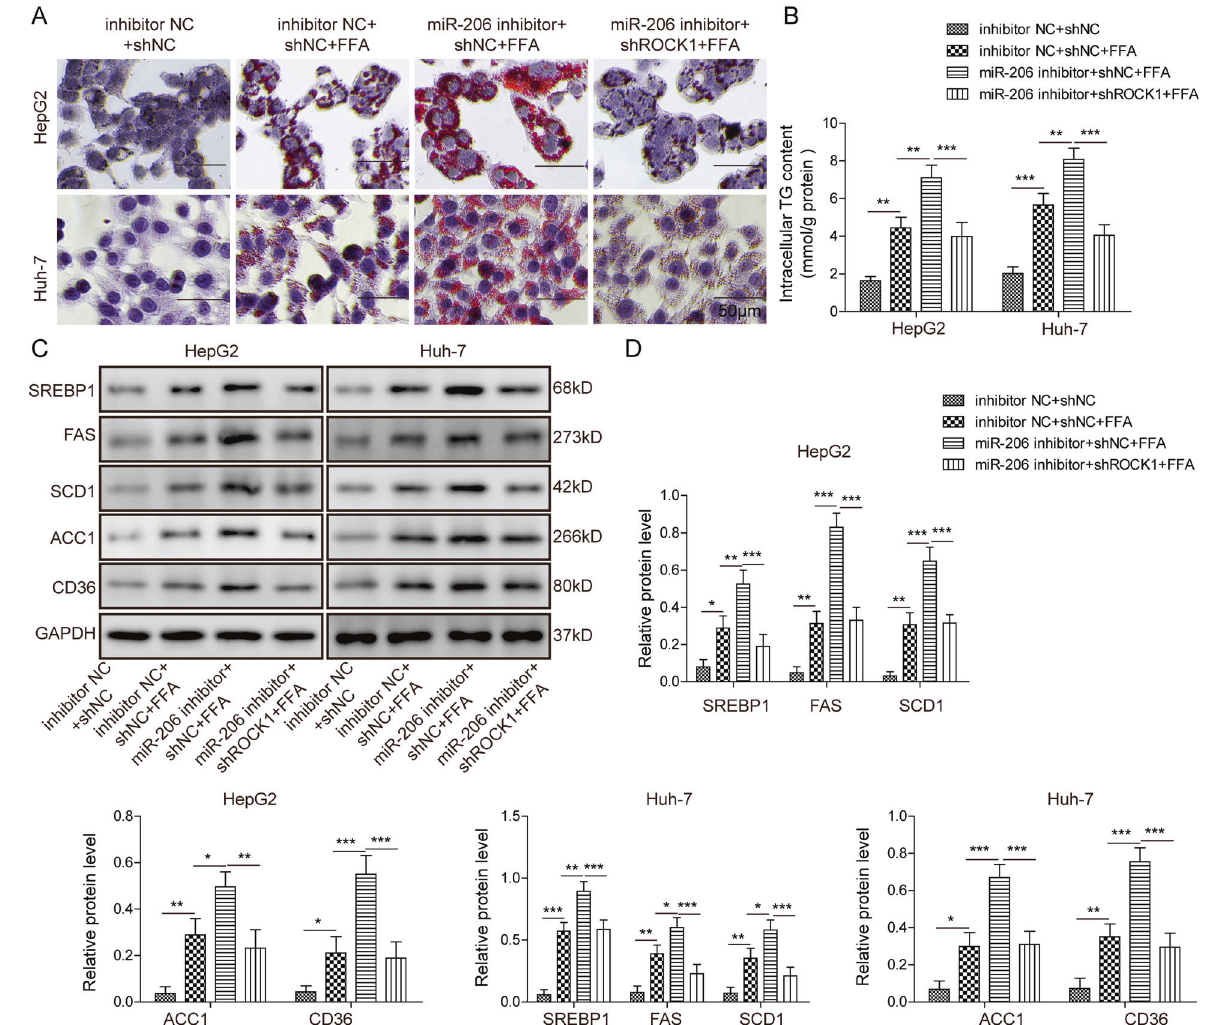
Fig. 4 miR-206 inhibited lipogenesis via ROCK1. A Representative oil-red o staining images of cells with the transfection of miR-206 inhibitor or NC together with sh-ROCK1 or sh-NC following FFA or control treatment. B Secreted TG levels in cells transfected with miR-206 inhibitor or NC together with sh-ROCK1 or sh-NC following FFA or control treatment. C Protein levels of lipogenesis-related proteins in cells with the transfection of miR-206 inhibitor or NC together with sh-ROCK1 or sh-NC following FFA or control treatment. D Quanti fi cations of C . *p < 0.05, ** p < 0.01, and *** p <